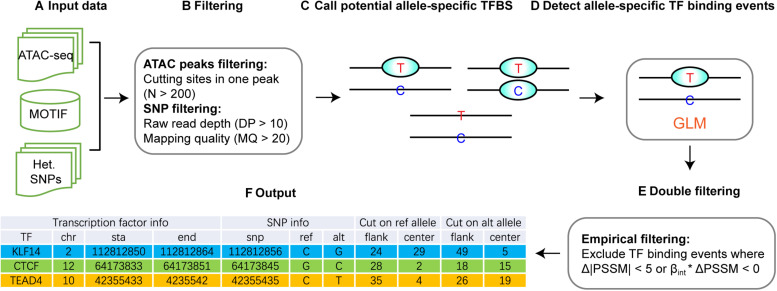
Workflow of regSNPs-ASB. (A) The input data for regSNPs-ASB are: (1) ATAC-seq raw read counts in a standard BAM format, (2) prior knowledge of TF binding motifs from the public domain, and (3) a vcf file with heterozygous SNP loci. (B) The first round of filtering considers only open-chromatin regions with a high amount of transposase cut sites and removal of SNPs with low mapping quality and read depth. (C) Call potential allele-specific TF-binding sites containing heterozygous SNPs. (D) Detect ASB events using GLM to identify allele-specific TF binding. (E) The second round of filtering requires the predicted ASB to have a high magnitude difference between reference and alternative alleles, as well as consistency in beta and PSSM values. (F) The output of regSNPs-ASB is a list of ASB events with associated TF information, regulatory SNP information, and corresponding ATAC-seq read counts from different alleles for each technical replicate.